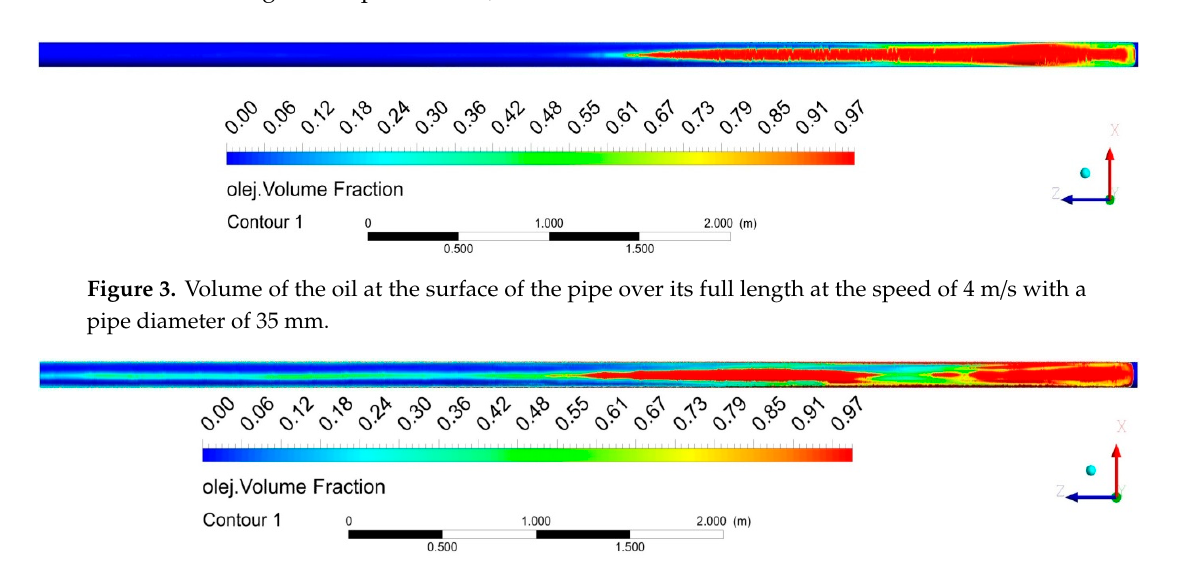
Figure 4. Volume of the oil at the surface of the pipe over its full length at the speed of 5 m / s with a pipe diameter of 35 mm.